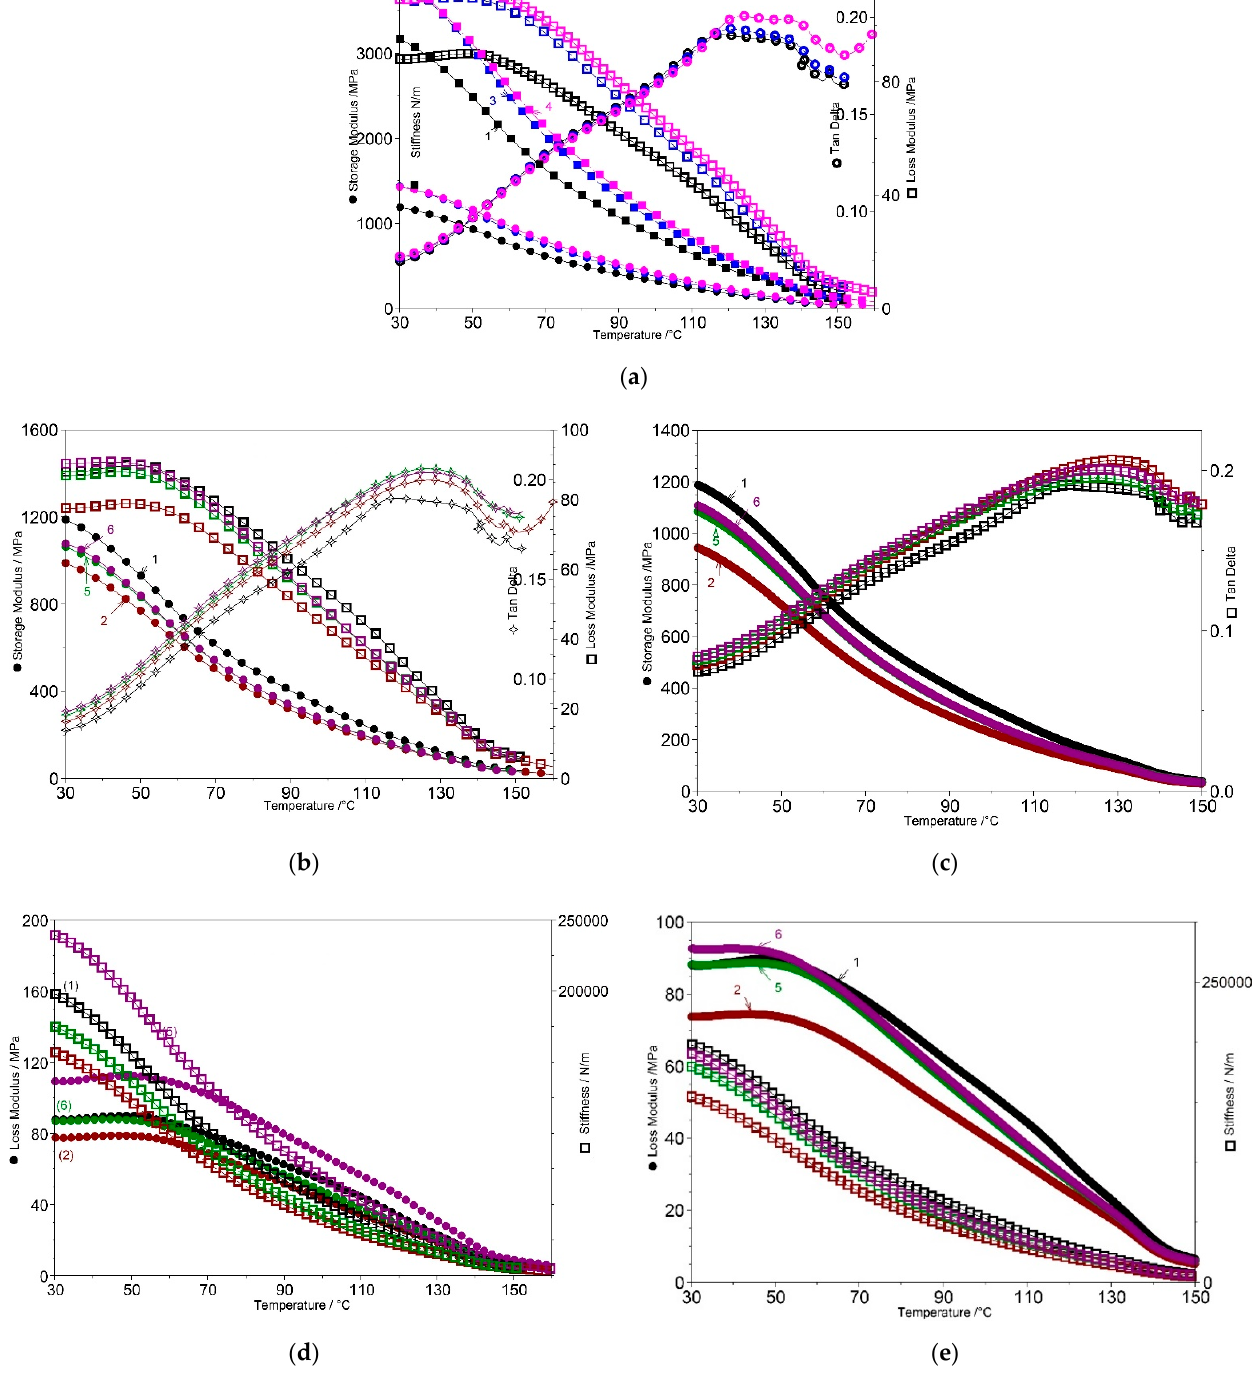
Figure 10. Dynamic mechanical analysis (DMA) analysis. Storage modulus ( ), Stiffness modulus ( ), tan δ ( ), and loss modulus ( ) as a function of temperature (1-PPW (black color), 3-PPW/n-Clay 5% (blue color), 4-PPW/n-Clay 10% (purple color)) ( a ); Storage modulus ( ), tan δ ( ), and loss modulus ( ) as a function of temperature (1-PPW (black color), 2-PPW/SBSBC (wine color), 5-PPW/SBSBC/n-Clay 5% (olive color), 6-PPW/SBSBC/n-Clay 10%) (purple color) ( b ); Storage modulus ( ), and tan δ ( ) as a function of temperature (1-PPW (black color), 2-PPW/SISBC (wine color), 5-PPW/SISBC/n-Clay 5% (olive color), 6 PPW/SISBC/n-Clay 10% (purple color)) ( c ); Loss modulus ( ) and stiffness ( ) as a function of temperature (1-PPW (black color), 2-PPW/SBSBC (wine color), 5-PPW/SBSBC/n-Clay 5% (olive color), 6 PPW/SBSBC/n-Clay 10% (purple color)) ( d ); Loss modulus ( ) and stiffness ( ) as a function of temperature (1-PPW (black color), 2-PPW/SISBC (wine color), 5-PPW/SISBC/n-Clay 5% (olive color), 6-PPW/SISBC/n-Clay 10% (purple color)) ( e ). The addition of n-clay in the PPW matrix resulted in a noticeable increase in stiffness, as reflected in the increase in storage modulus values compared to the neat PPW sample, due to the reduced mobility of the polymer chain segments. A high reinforcement in all composites was recorded at 90 °C, when the storage modulus showed an improvement when increasing the amount of n-clay (Figure 10a). Loss modulus curves of the function of temperature recorded a peak, visible around 50 ° C, attributed to α relaxation in PP, due to the slip and rotation of the crystalline lamellae [67]. This relaxation was enhanced in the presence of n-clay and more observable for the 10 wt% amount. Similar findings were recorded by Majka et al. [68]. The incorporation of synthesized elastomers in the PPW phase led to a decrease of storage modulus ( E ′ ), attributed to an increase of elasticity, with a more accentuated effect